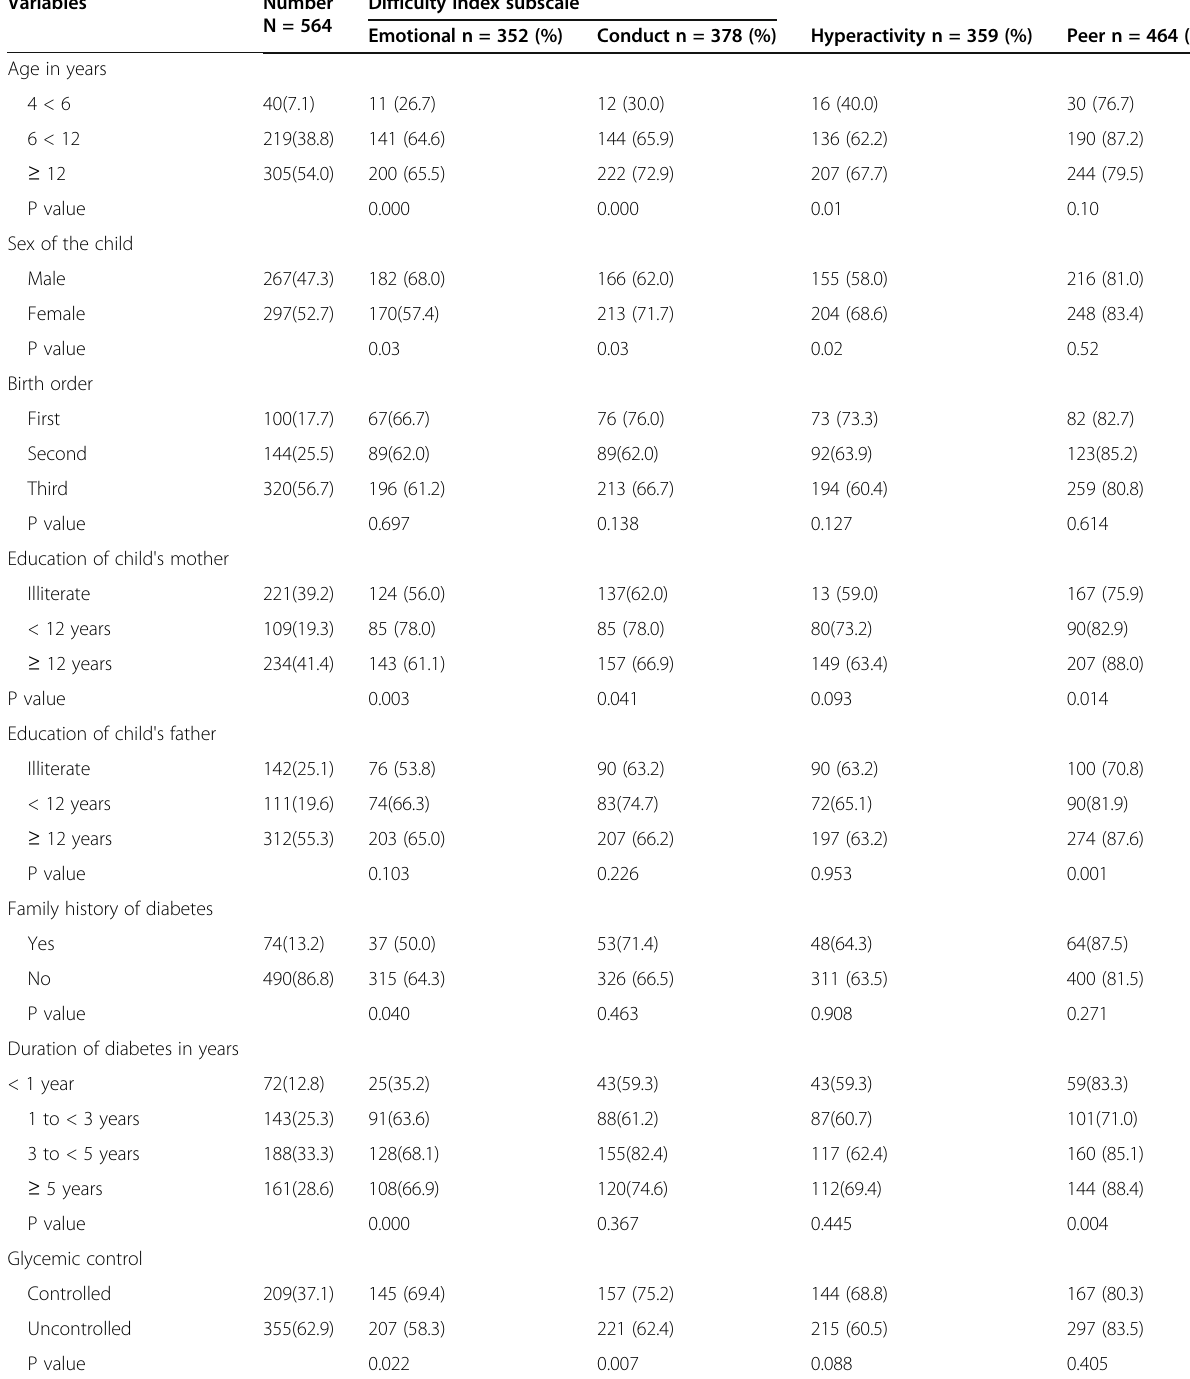
Table 2 Factors associated with abnormal SDQ